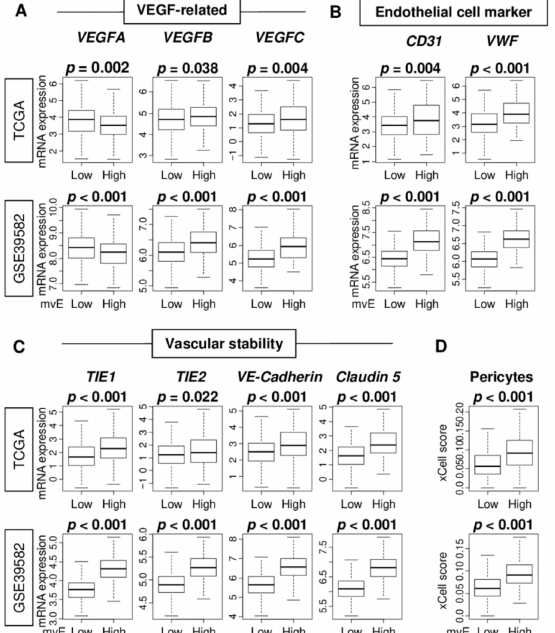
Figure 1. Association of the microvessel endothelial cells (mvE) with expression of vessel-related genes in the Cancer Genome Atlas (TCGA) and GSE39582 cohorts. Boxplots of the comparison of ( A ) vascular endothelial growth factor (VEGF)-related genes, VEGF-A, VEGF-B, and VEGF-C; and ( B ) endothelial cell-related genes, CD31 and VWF; and ( C ) vascular stability-related genes, TIE1, TIE2, VE-Cadherin, and Claudin 5; and ( D ) abundance of pericytes between high and low mvE groups. The top one-fourth was used as a cut-off to divide low and high groups for each cohort. p -value was calculated by the Mann–Whitney U